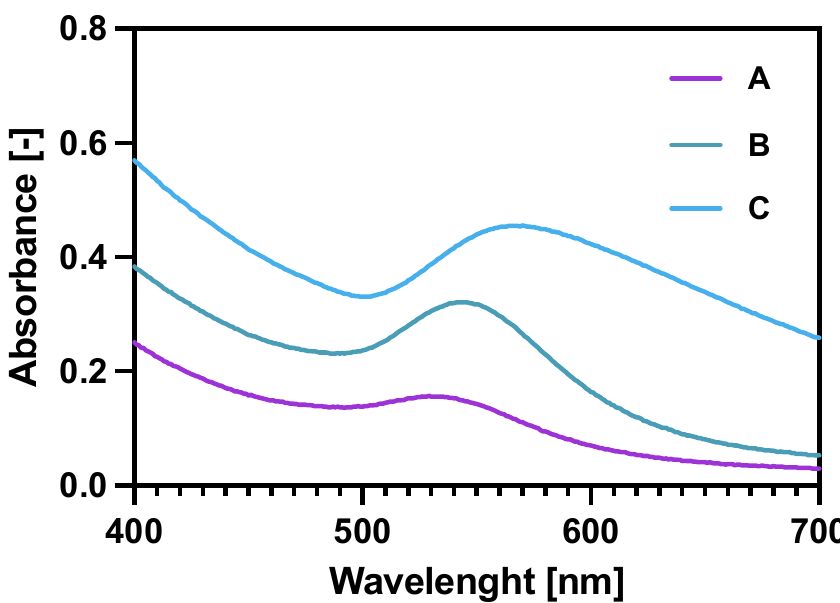
Figure 2. UV-vis spectra for gold coated NPs: A—Fe 3 O 4 : Au 5:1 ( w / w ); B—Fe 3 O 4 : Au 2.5:1 ( w / w ); C—Fe 3 O 4 : Au 1.25:1 ( w / w ).